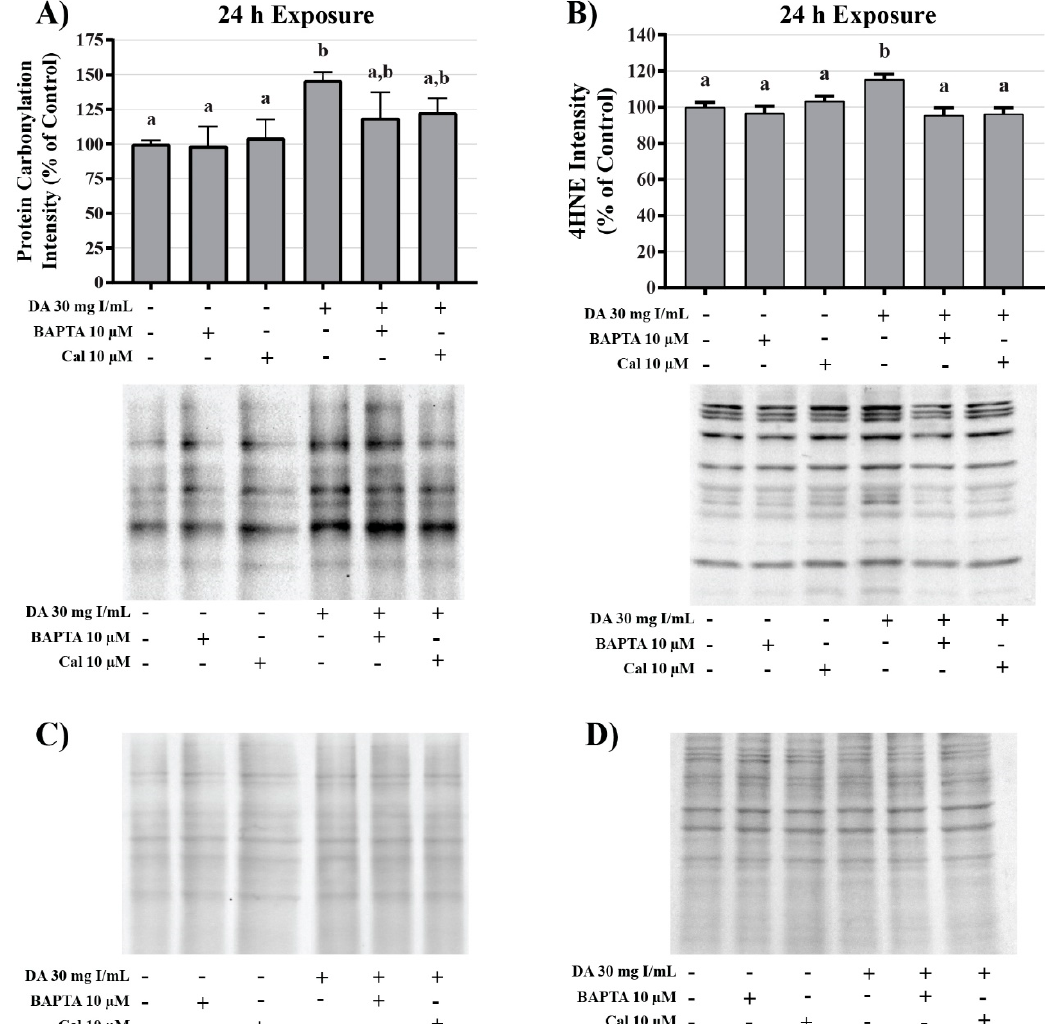
Figure 21. Effects of BAPTA-AM or calpeptin pretreatment on oxidative stress in HK-2 cells. Pretreatment with BAPTA-AM or calpeptin slightly decreased protein carbonylation and completely abrogated 4HNE adduct formation. Representative blots and cumulative densitometry included for protein carbonylation ( A ) and 4HNE adduct formation ( B ) following 24 h exposure to DA. Panel ( C ) depicts protein loading of protein carbonylation membrane and panel ( D ) depicts protein loading for 4HNE membrane. Different superscripts (a,b) indicate a statistical difference ( p < 0.05) between groups. Values represent mean ± SEM for three independent experiments.